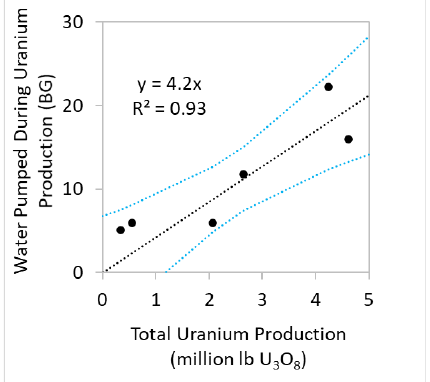
Figure 5. Volume of water pumped during the uranium production phase as a function of uranium produced (as lb U 3 O 8 ) for the six ISR operations listed in Table A1. Compiled data used to construct these graphs as well as associated references are publicly available online [18]. Note BG = billion gallons. Black line is the linear trend line and blue lines are the 95 percent confidence intervals.